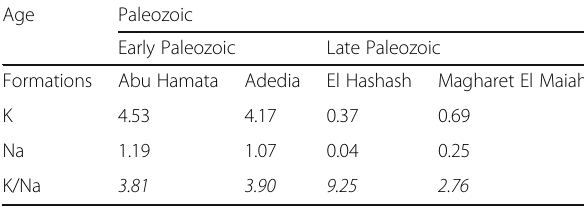
Table 6 K/Na ratio of studied Paleozoic